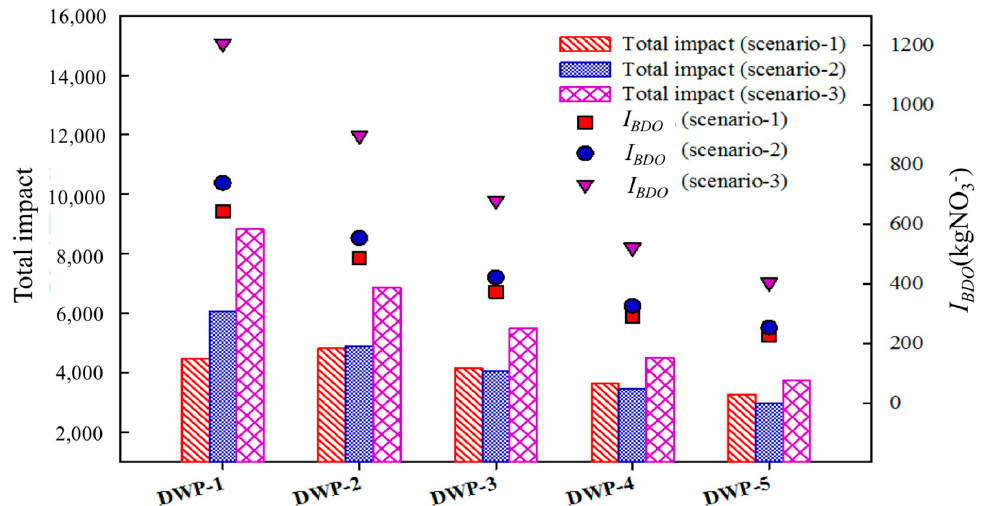
Figure 4. Comparison of total environmental impact and BDO characterization results among different scenarios at different longitudinal parts of receiving water using 1DCCM in a full LCA analysis relevant to WWTP. Five downstream water body areas are defined here: DWP-1 (distance of 100 m from downstream water body part to emission point), DWP-2 (20,000 m), DWP-3 (40,000 m), DWP-4 (60,000 m), and DWP-5 (80,000 m). With respect to the escalation from intermediate treatment to tertiary treatment, scenario 1 showed lower I BDO results than scenario 2 at all downstream locations, but the magnitude of reduction decreased gradually from DWP-1 (95.16 kgNO 3 − ) to DWP-5 (26.56 kgNO 3 − ). We compared total impact between scenario 1 and scenario 2, with scenario 1 being lower than scenario 2 at DWP-1 but